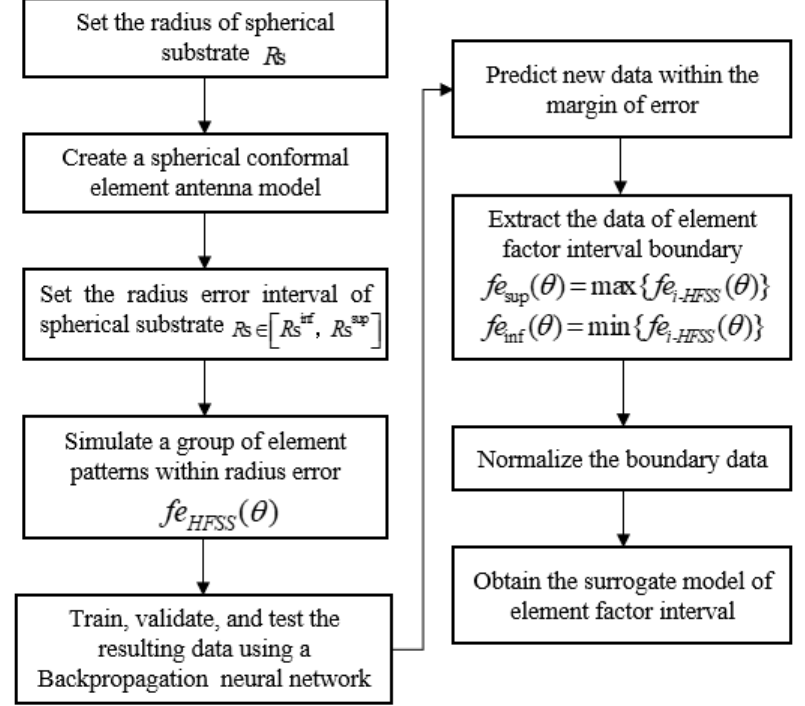
Figure 3. The flow chart of the surrogate model.